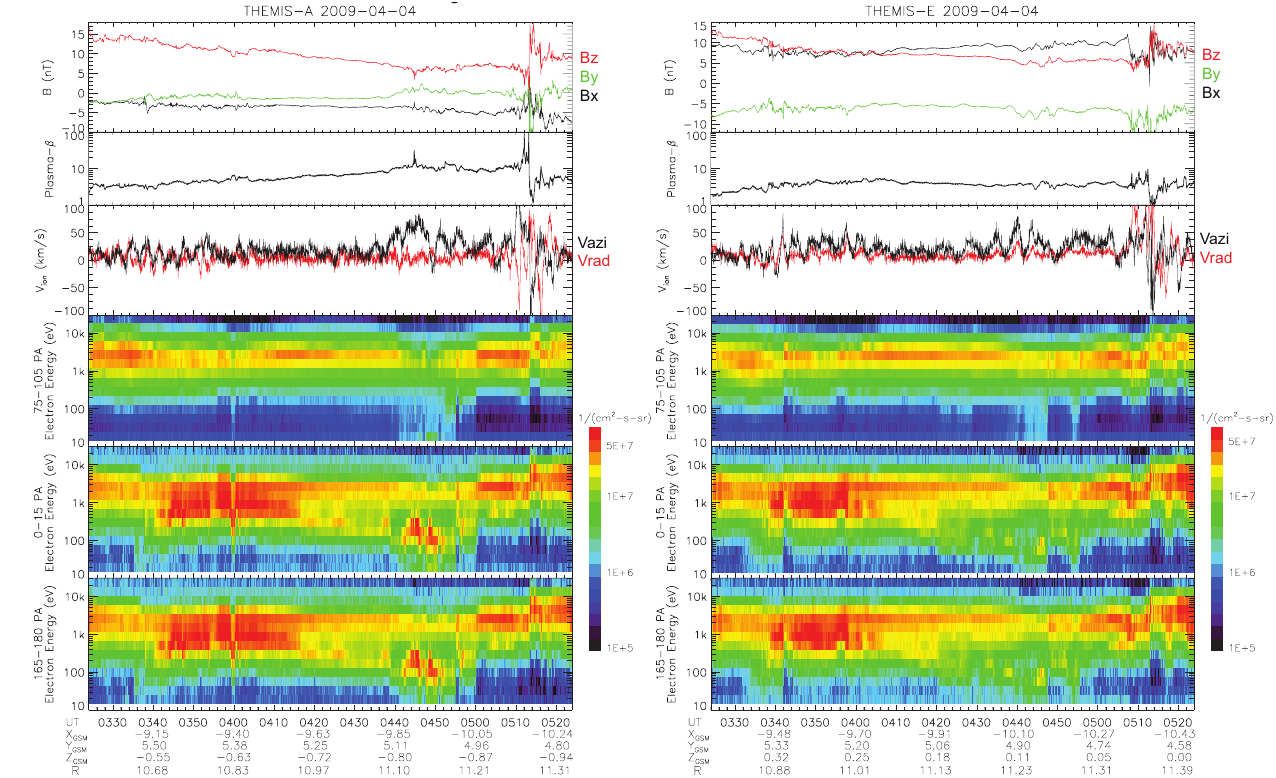
Fig. 9. (a) TH-A observations on 4 April 2009 in the same format as in Fig. 4. (b) TH-E observations during the same time interval and in the same plot